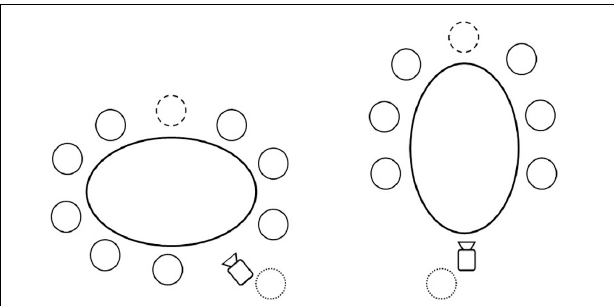
FIGURE 1 | Illustration of two usual set-ups of the meeting recordings including the camera location. Small circles illustrate persons; the circle with the dotted line behind the camera illustrates the experimenter; the circle with the dashed line at the top of the table illustrates team